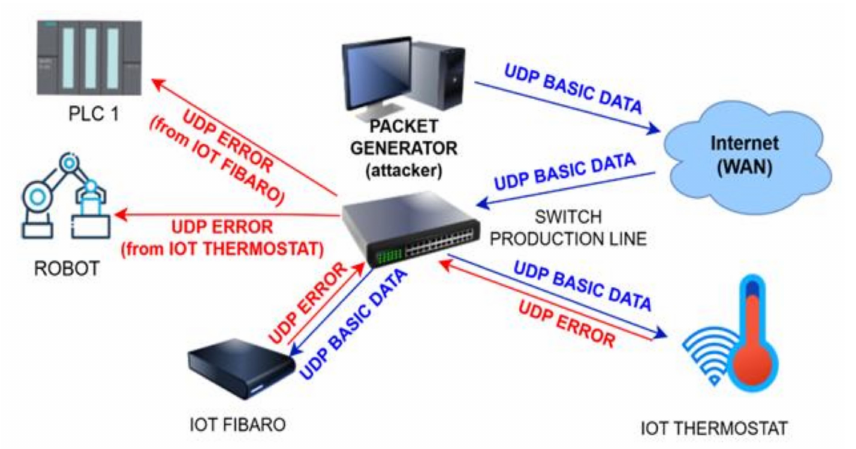
Figure 7. A visual illustration of the scenario 3 attack.